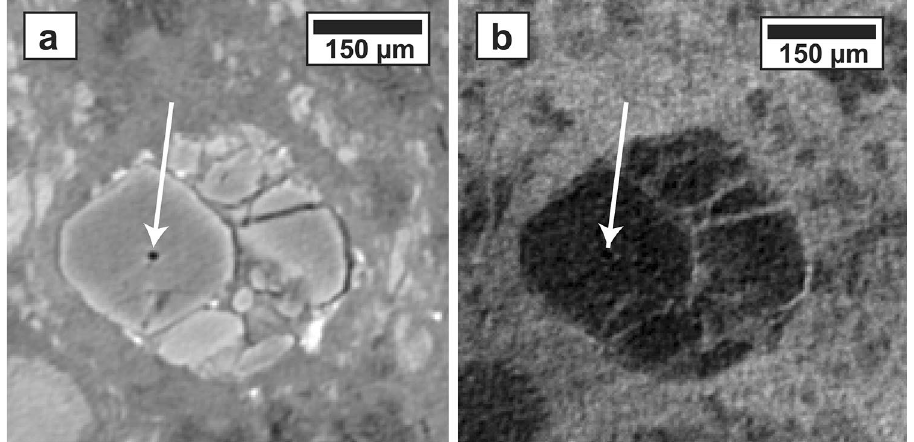
Figure 3. ( a ) XCT slice 316 (magnified by 2x) of Air scan showing an isolated pore (the largest of 5 visible in this crystal) in an Fe-bearing olivine chondrule that has not been infiltrated with xenon ( b